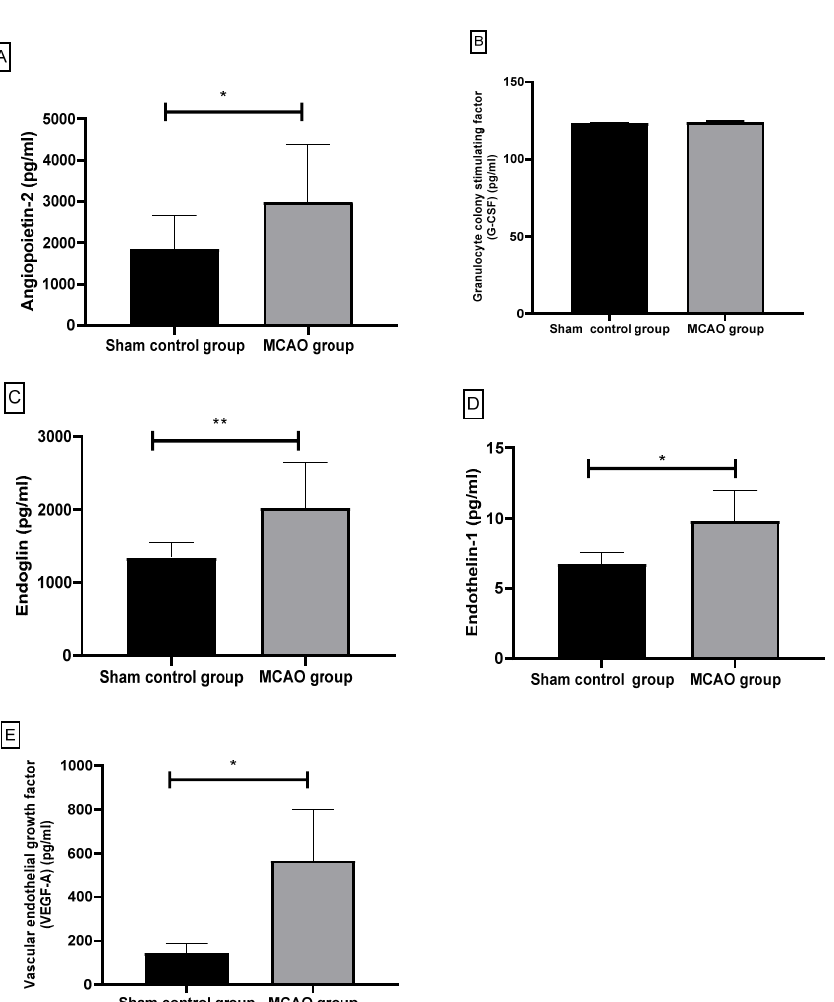
Figure 5. Comparison of angiogenic markers levels ( A ) Angiopoietin-2 (pg/mL), ( B ) Granulocyte colony-stimulating factor (G-CSF) (pg/mL), ( C ) Endoglin (pg/ml), ( D ) Endothelin-1 (ET-1) (pg/mL), ( E ) Vascular endothelial growth factor-A (VEGF-A) (pg/mL) between sham control group and middle cerebral artery occlusion (MCAO) group. Data are expressed as mean +/ − standard deviation. * Significant at (<0.05) and ** significant at (<0.01) as compared to the sham control